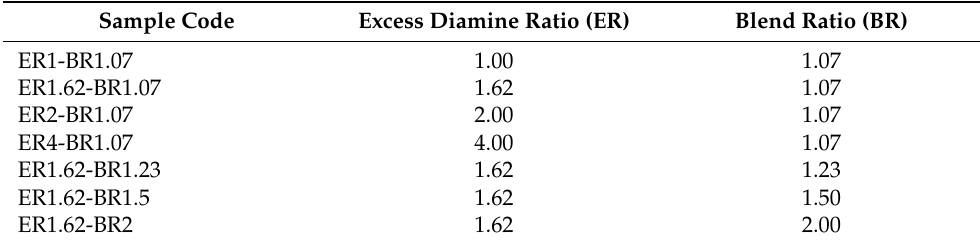
Table 1. Excess diamine ratio and blend ratio employed in experiments.